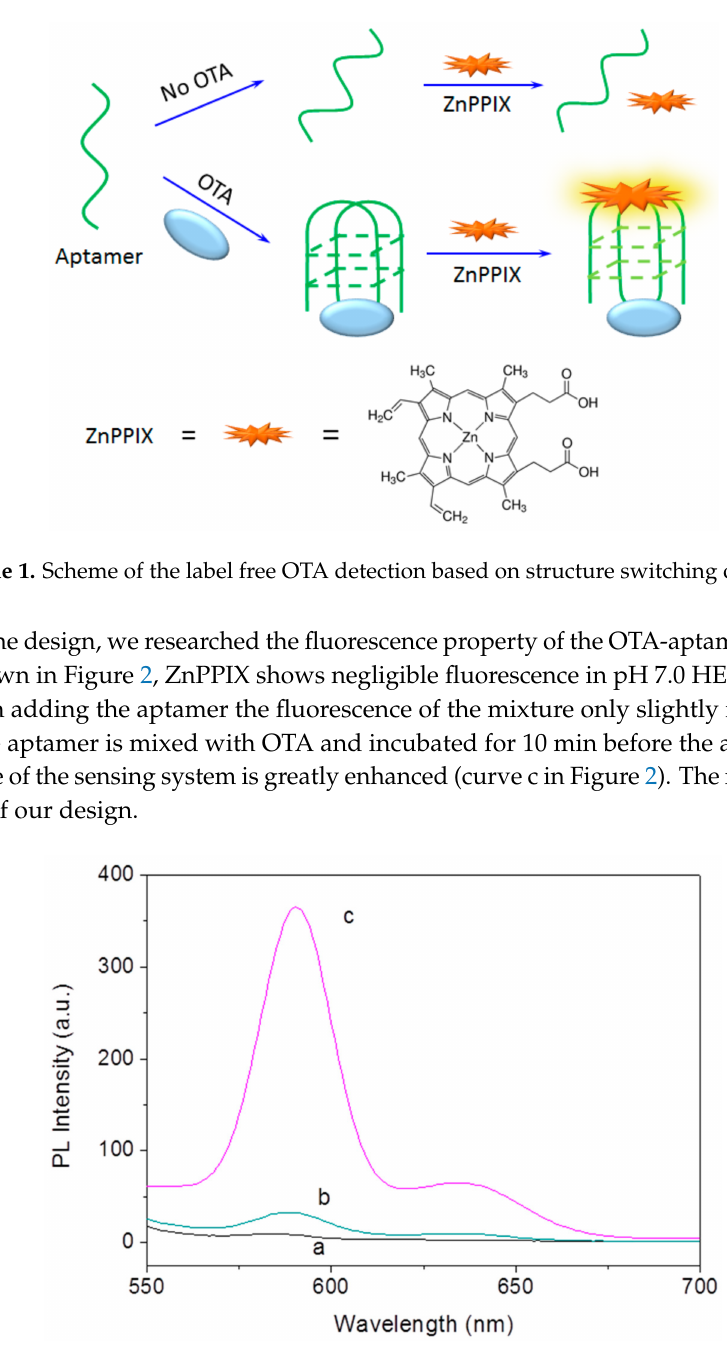
Figure 2. The emission spectra of ZnPPIX ( a ), ZnPPIX + aptamer ( b ), and ZnPPIX + aptamer + OTA ( c